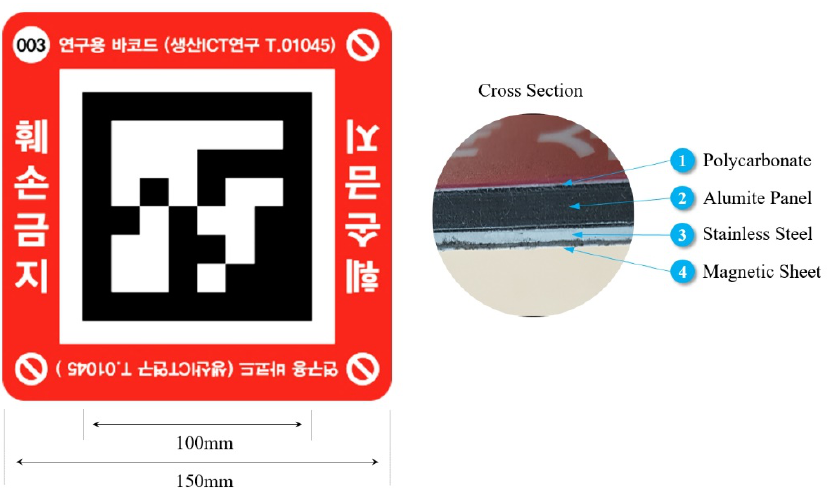
Figure 7. Design details of proposed marker.